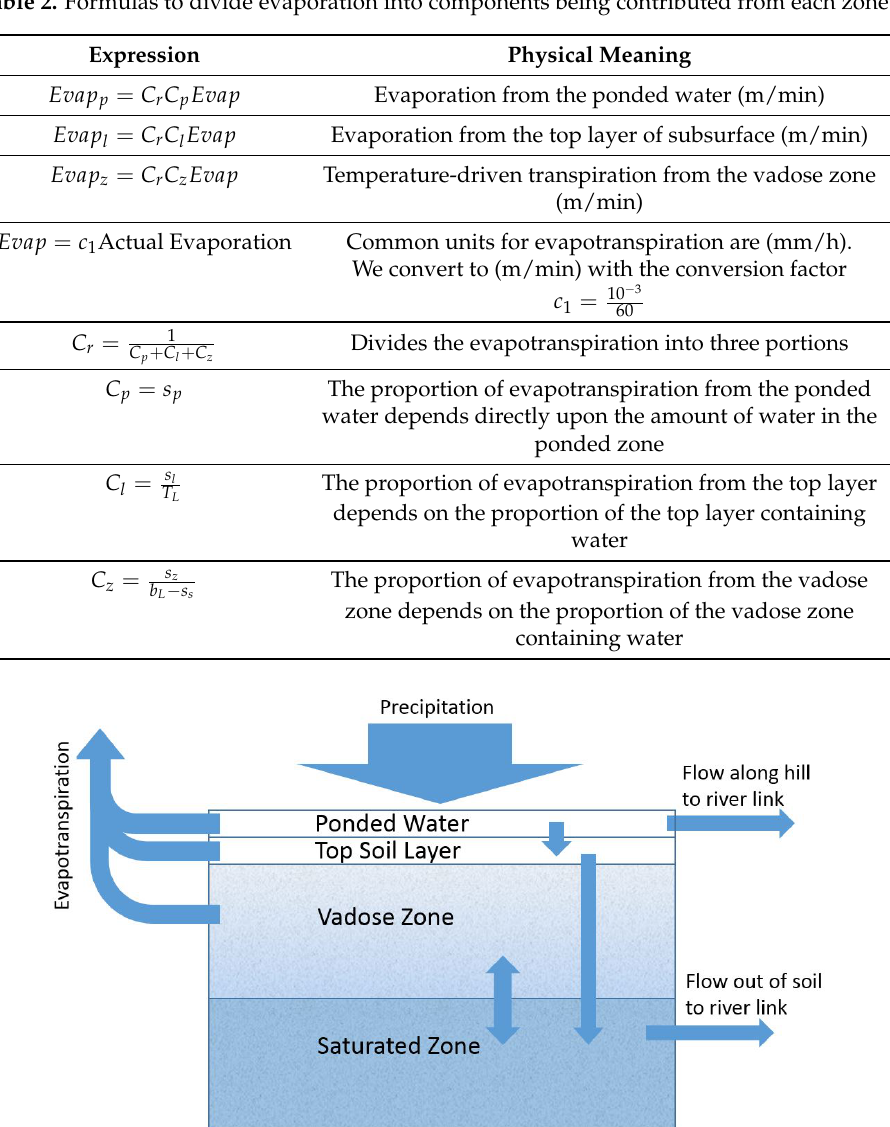
Table 2. Formulas to divide evaporation into components being contributed from each zone.